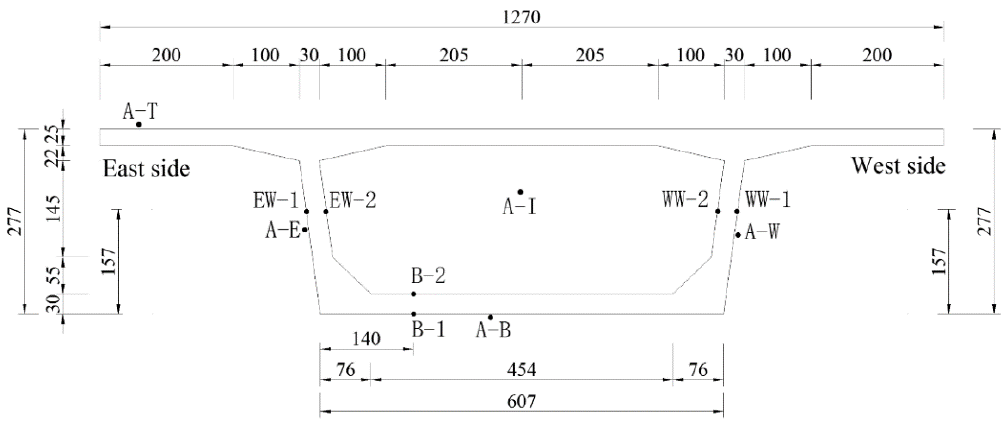
Figure 9. Layout of cross-section of box girder (cm).